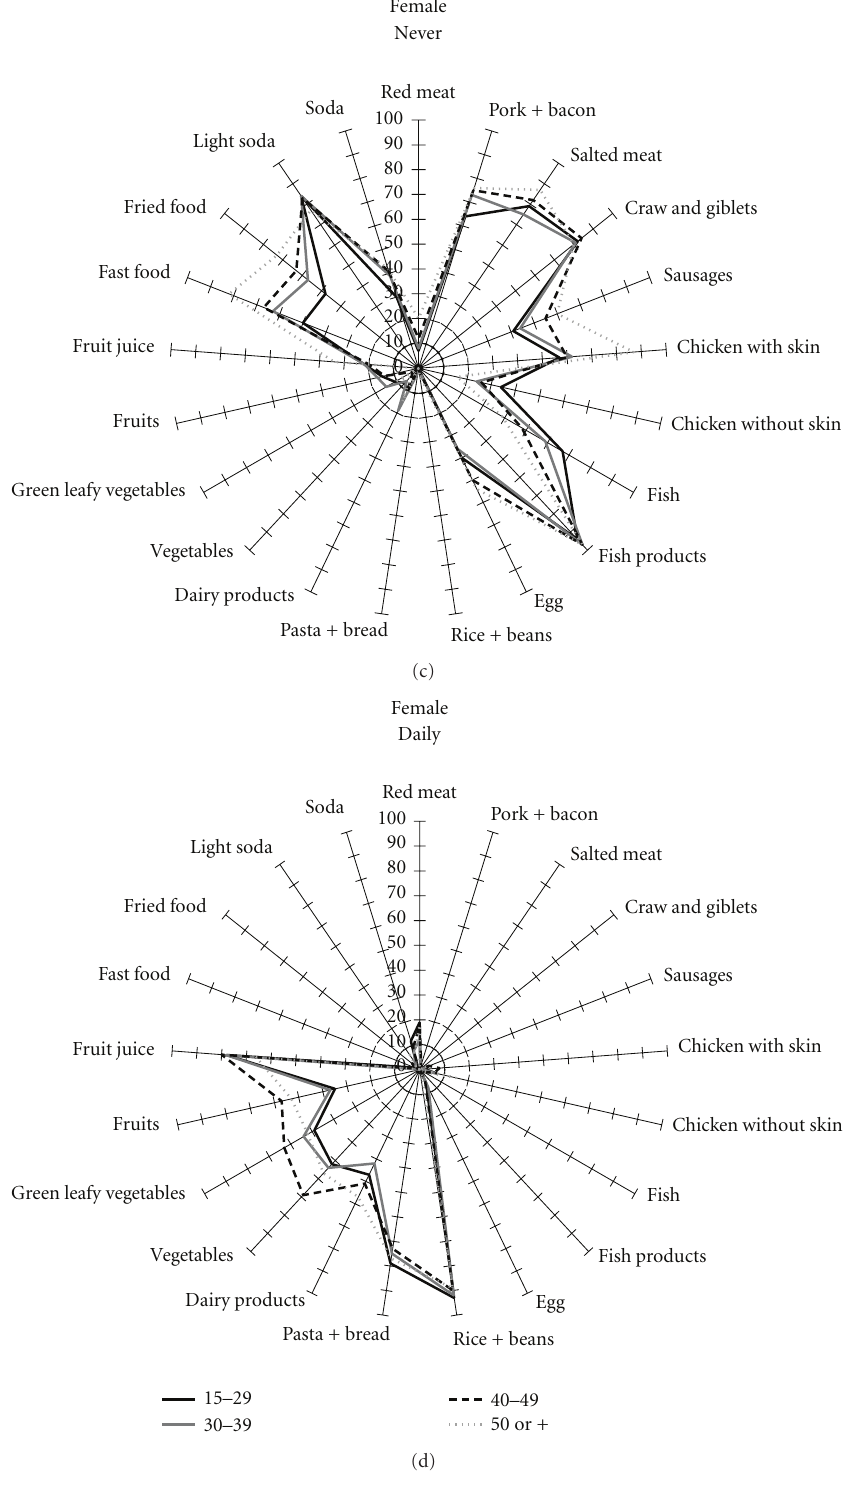
Figure 2: Food frequency consumed daily and never according to age, stratified by sex, SESI